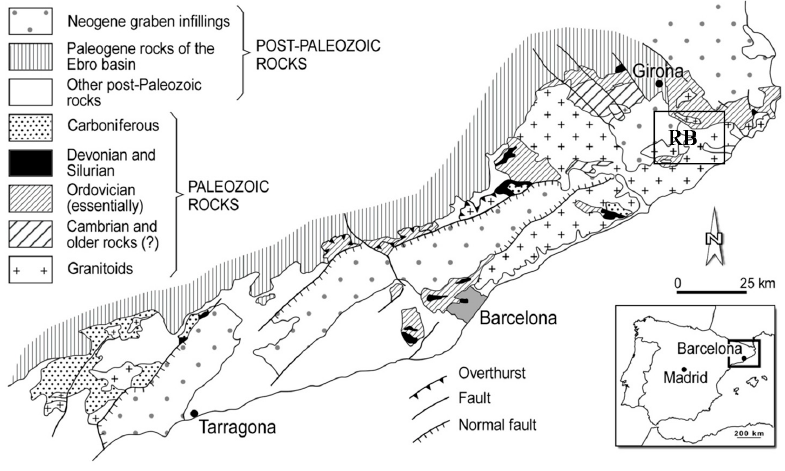
Figure 1. Geological map of Catalan Coastal Ranges, RB: Ridaura basin.